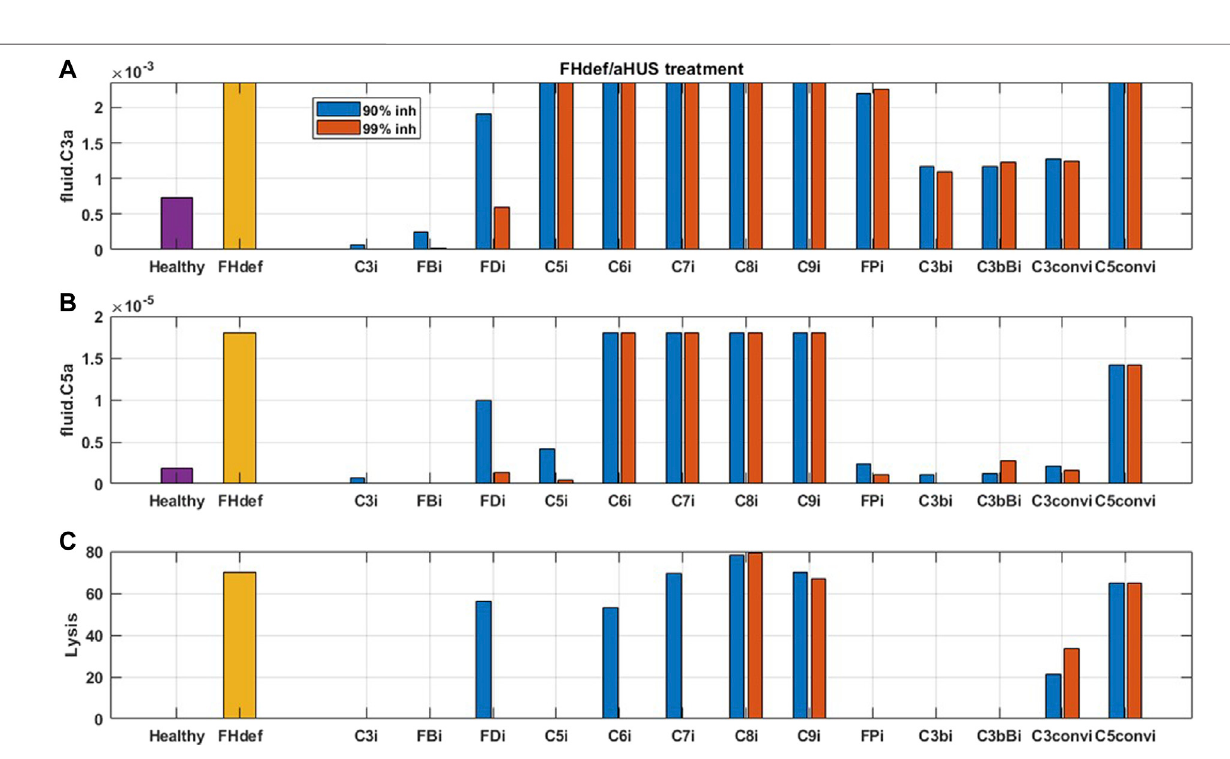
Frontiers in Pharmacology |